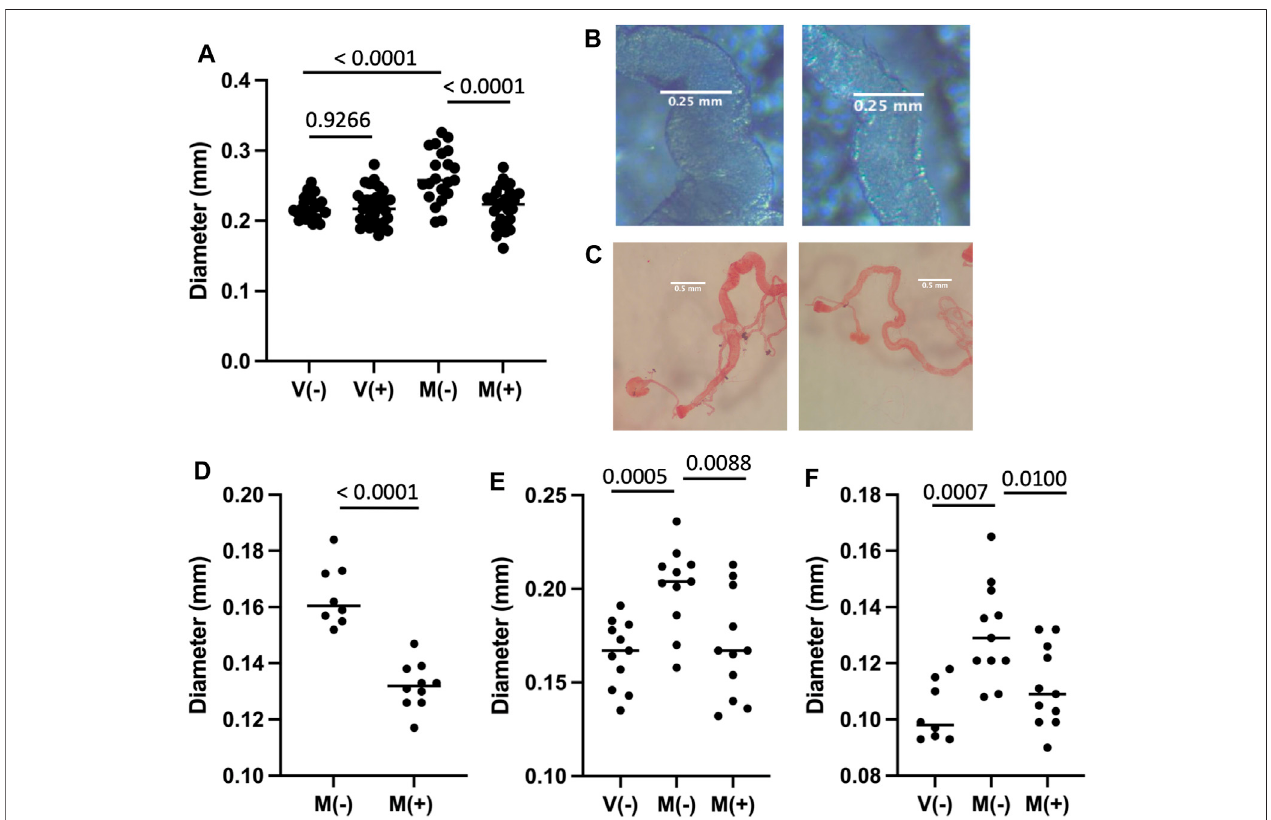
FIGURE5| Effectofmifepristoneonmidgutsize.Themidgutwasdissectedfromvirginfemales(V)ormatedfemales(M),maintainedfor12 daysintheabsence( − ) or presence (+) of 200 μ g/ml mifepristone, as indicated. Midgut tissue was dissected, mounted on slides, photographed, and the maximum midgut diameter was measuredusingImageJ.Statisticalcomparisonsareunpaired,two-sided t test,and p valuesarepresentedabovethegroups. (A , B) Progenyofcross w[1118]xyw;Elav- GS . (A) Maximum midgut diameter. The p value for signi fi cance with three comparisons is 0.0167. (B) Examples of midgut middle region. Left panel M( − ), right panel M(+). (C , D) w[1118] strain. (C) Examples of midgut, fi xed and stained with Oil Red O dye. Left panel M( − ), right panel M(+). (D) Maximum w[1118] strain midgut diameter quanti fi cation. The p value for signi fi cance with one comparison is 0.05. (E , F) Progeny of cross SREBP-R x UAS-mCherry . (E) Maximum midgut diameter. (F) PM diameter. The p value for signi fi cance with two comparisons is